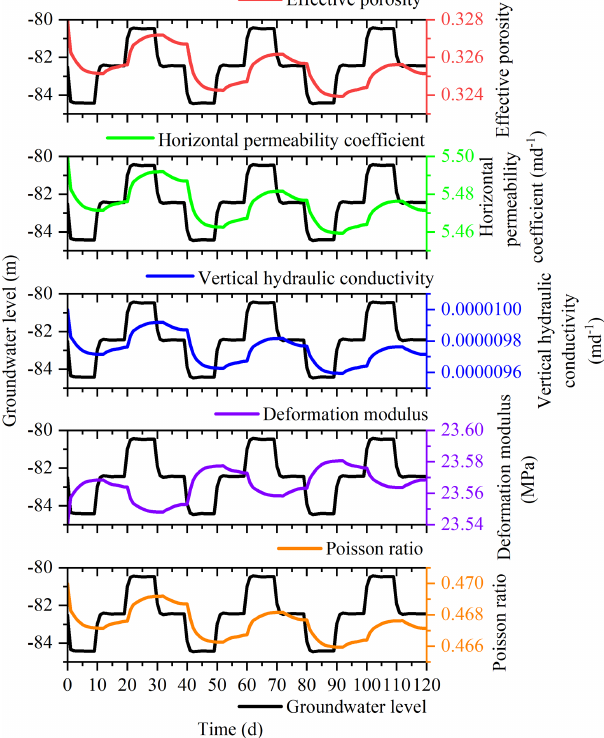
Figure 7. Parameter and water level with stress period in the fourth confined aquifer group under the first pumping and recharge